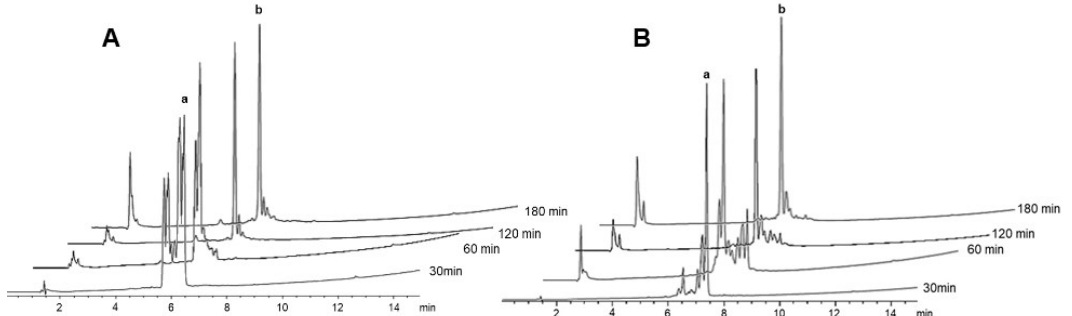
Figure 7. HPLC of the removal of the NO 2 groups from H-[Trp(Boc)-Arg(NO 2 )] 2 -Pro-NH-Rink-amide resin ( A ) and H-[Trp(Boc)-Arg(NO 2 )] 3 -Pro-NH-Rink-amide resin ( B ) using 2 M SnCl 2 -0.04 M phenol-0.2 M aq HCl in 2-MeTHF at 55 °C. a: protected peptide; b: unprotected peptide. elution: 5-95% of B into A in 15 min.